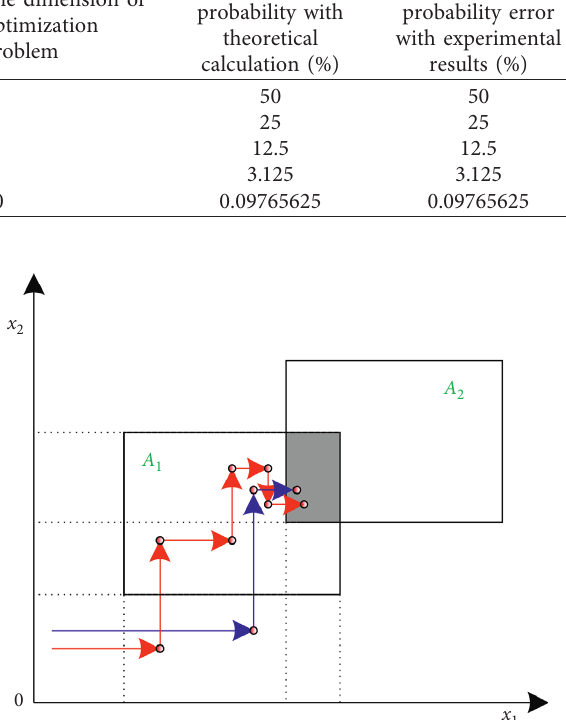
Figure 8: Continuous rolling revision selection process of feasible solutions for two-dimensional optimization